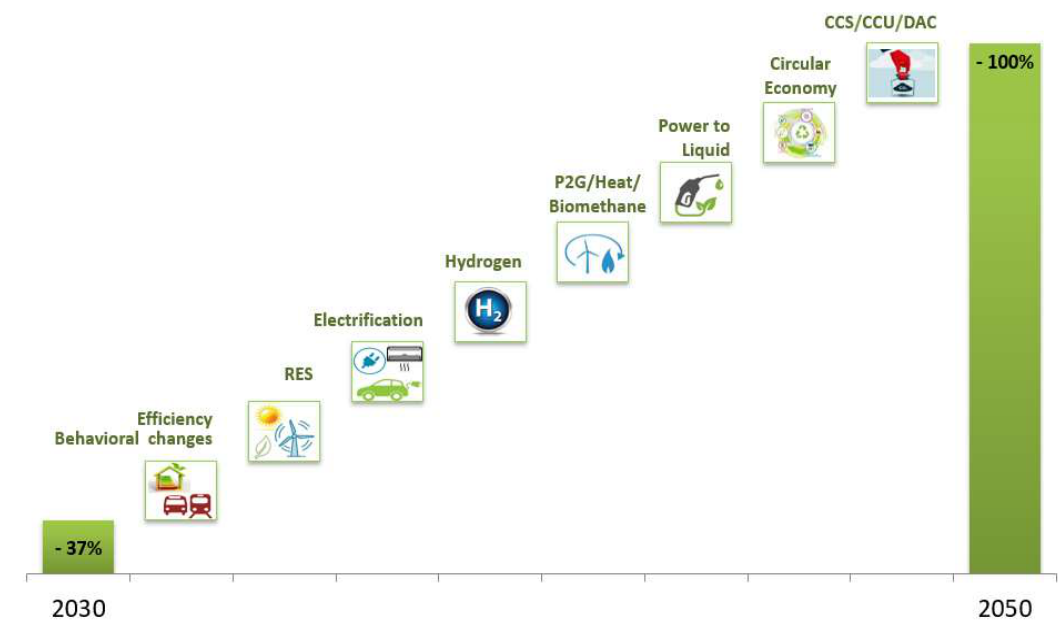
Figure 3. Main decarbonization options.